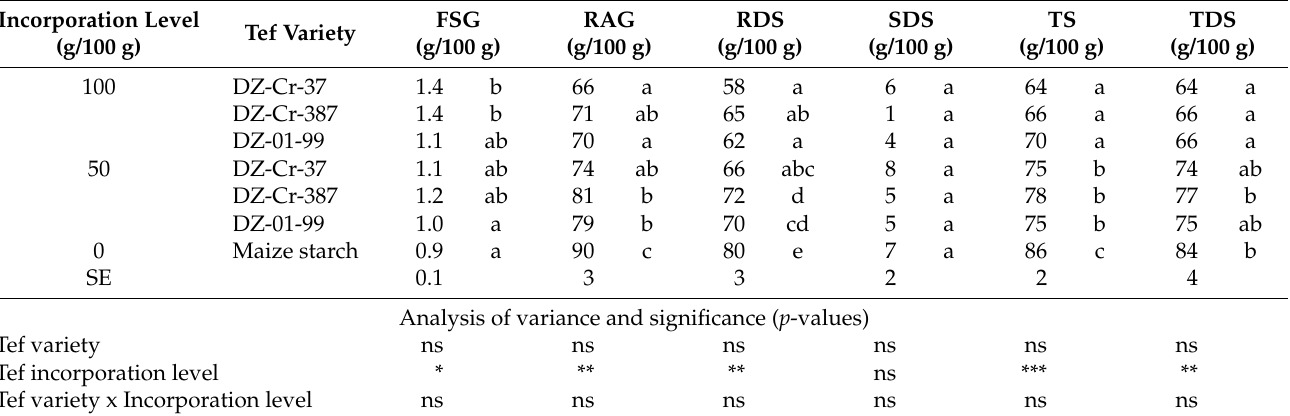
Table 4. Starch fractions of tef-enriched maize starch breads referred to bread dry